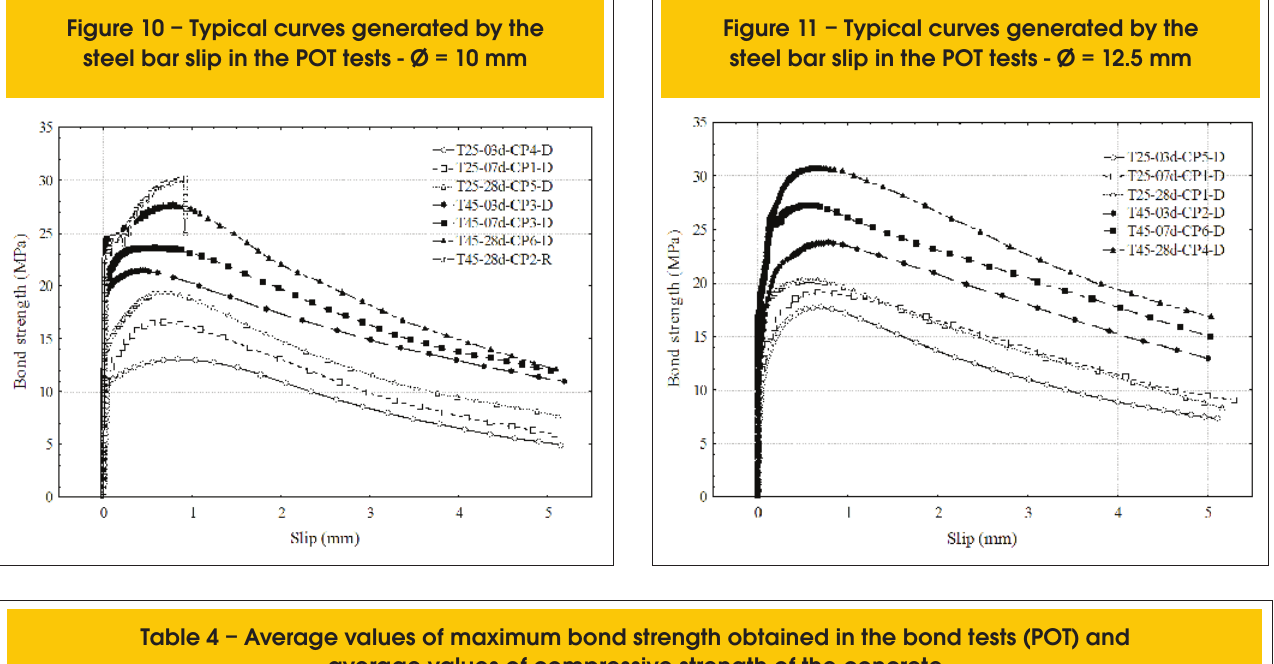
Figure 11 – Typical curves generated by the